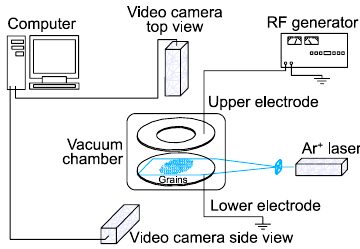
Figure 1. Scheme of the experimental